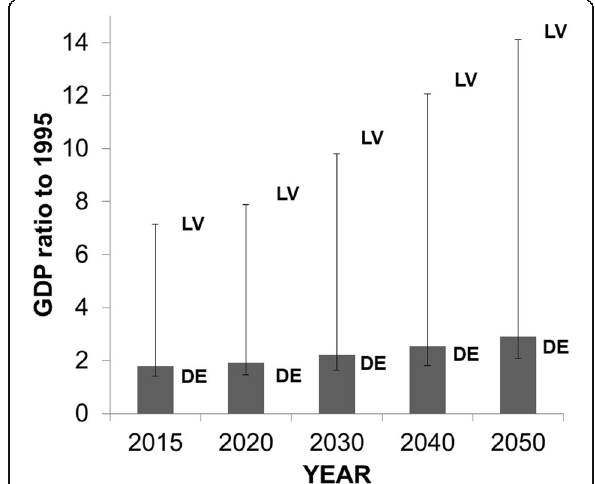
Fig. 1 Base Average EU GDP Ratio (weighted by population and showing deviation between maximum (Latvia- LV) and minimum (Germany - DE)